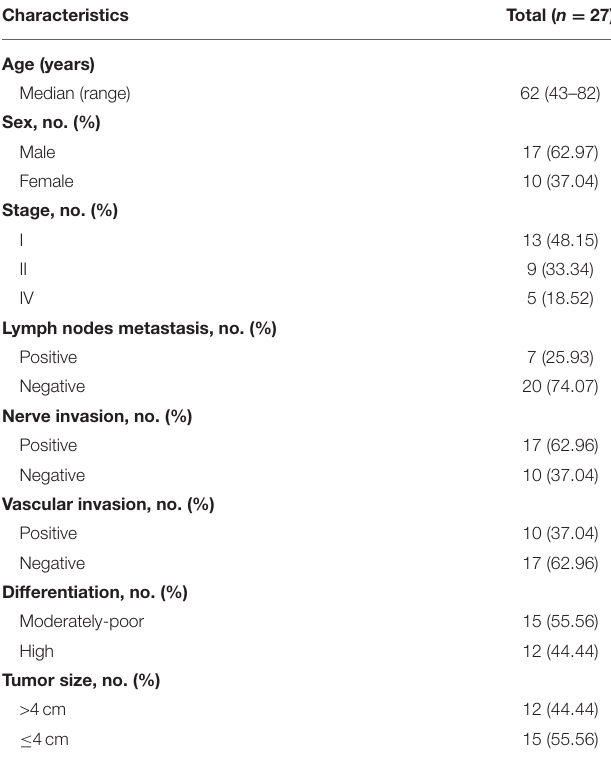
TABLE 1 | Clinical characteristics of enrolled patients.